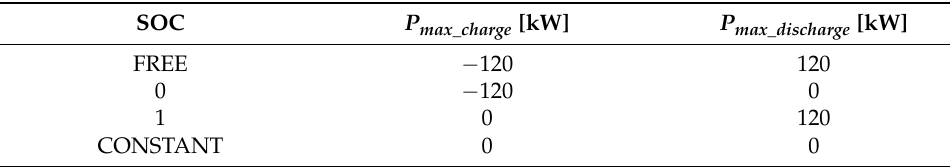
Table 6. Adjusted constraints on battery power according to the